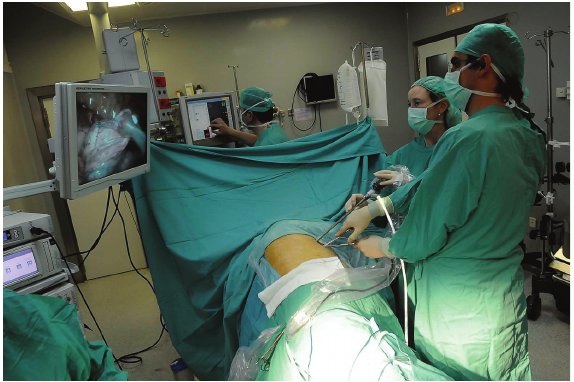
Figure 2: Surgeons in front of the